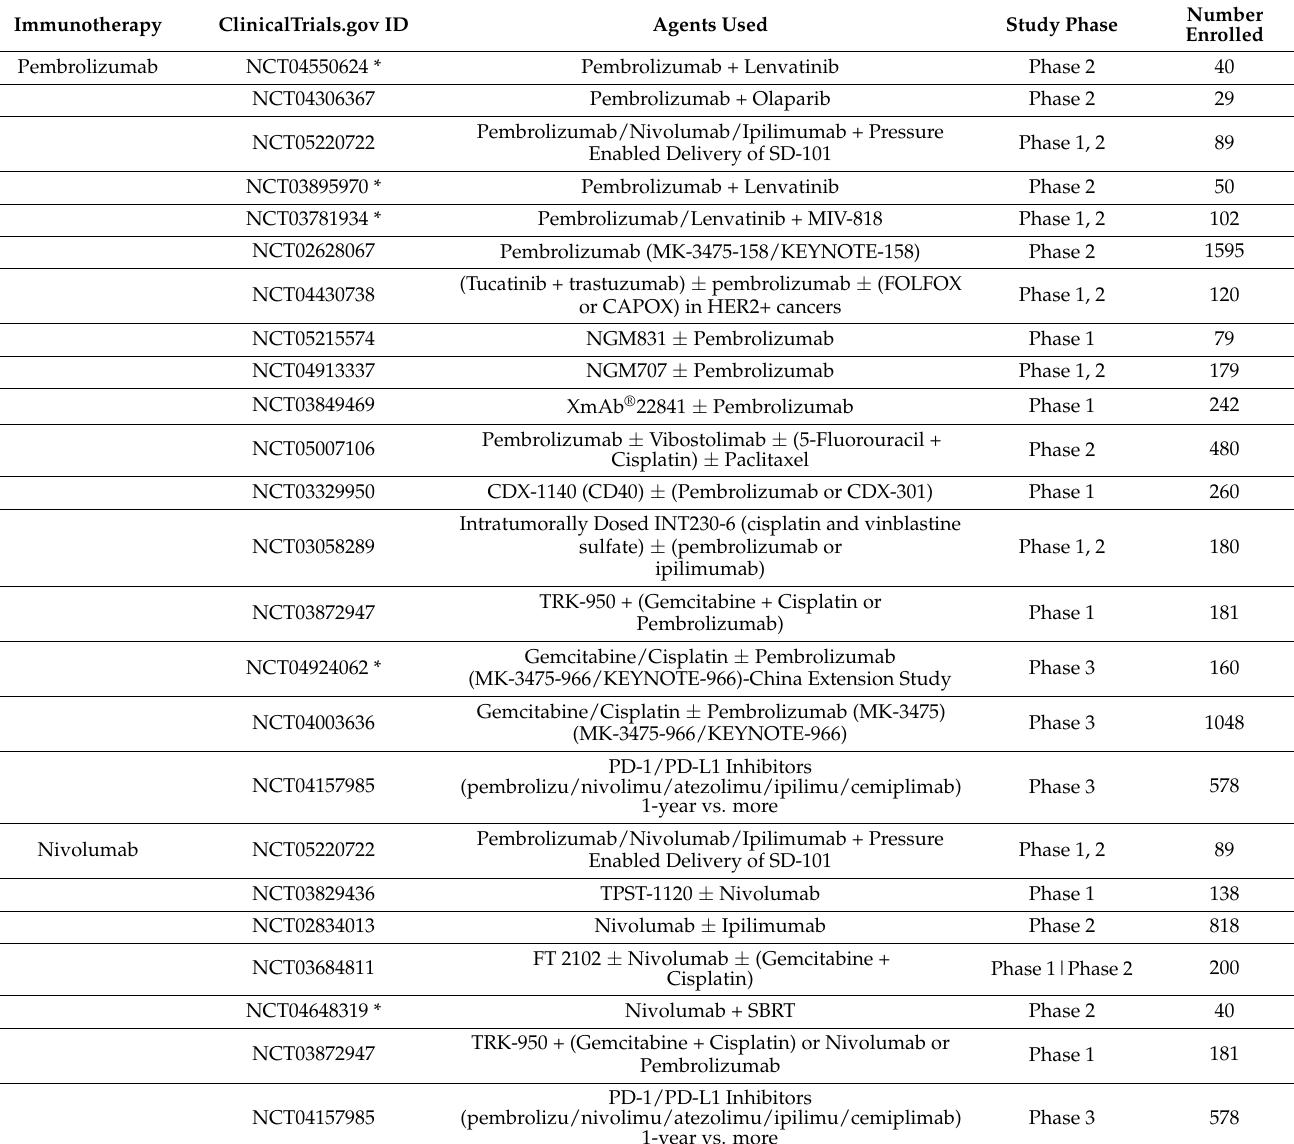
Table 4. Ongoing Immunotherapy-based Trials in